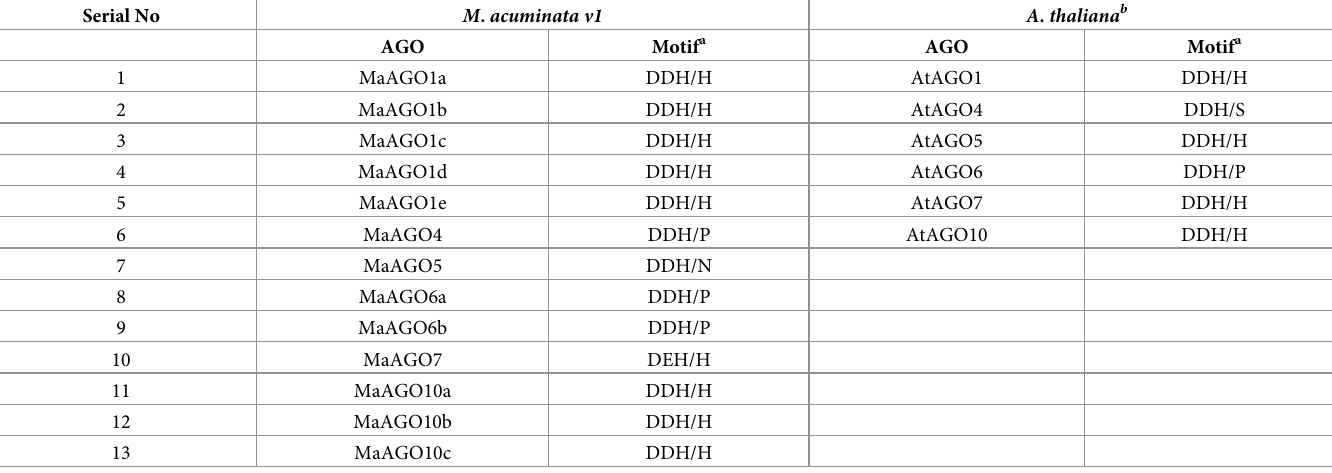
a Comparison of conserved motif corresponds to D760, D845, H986/H798 of Arabidopsis AGO1; D: aspartate, H: histidine, P: proline, R: arginine, S: serine and Y: tyrosine. b From